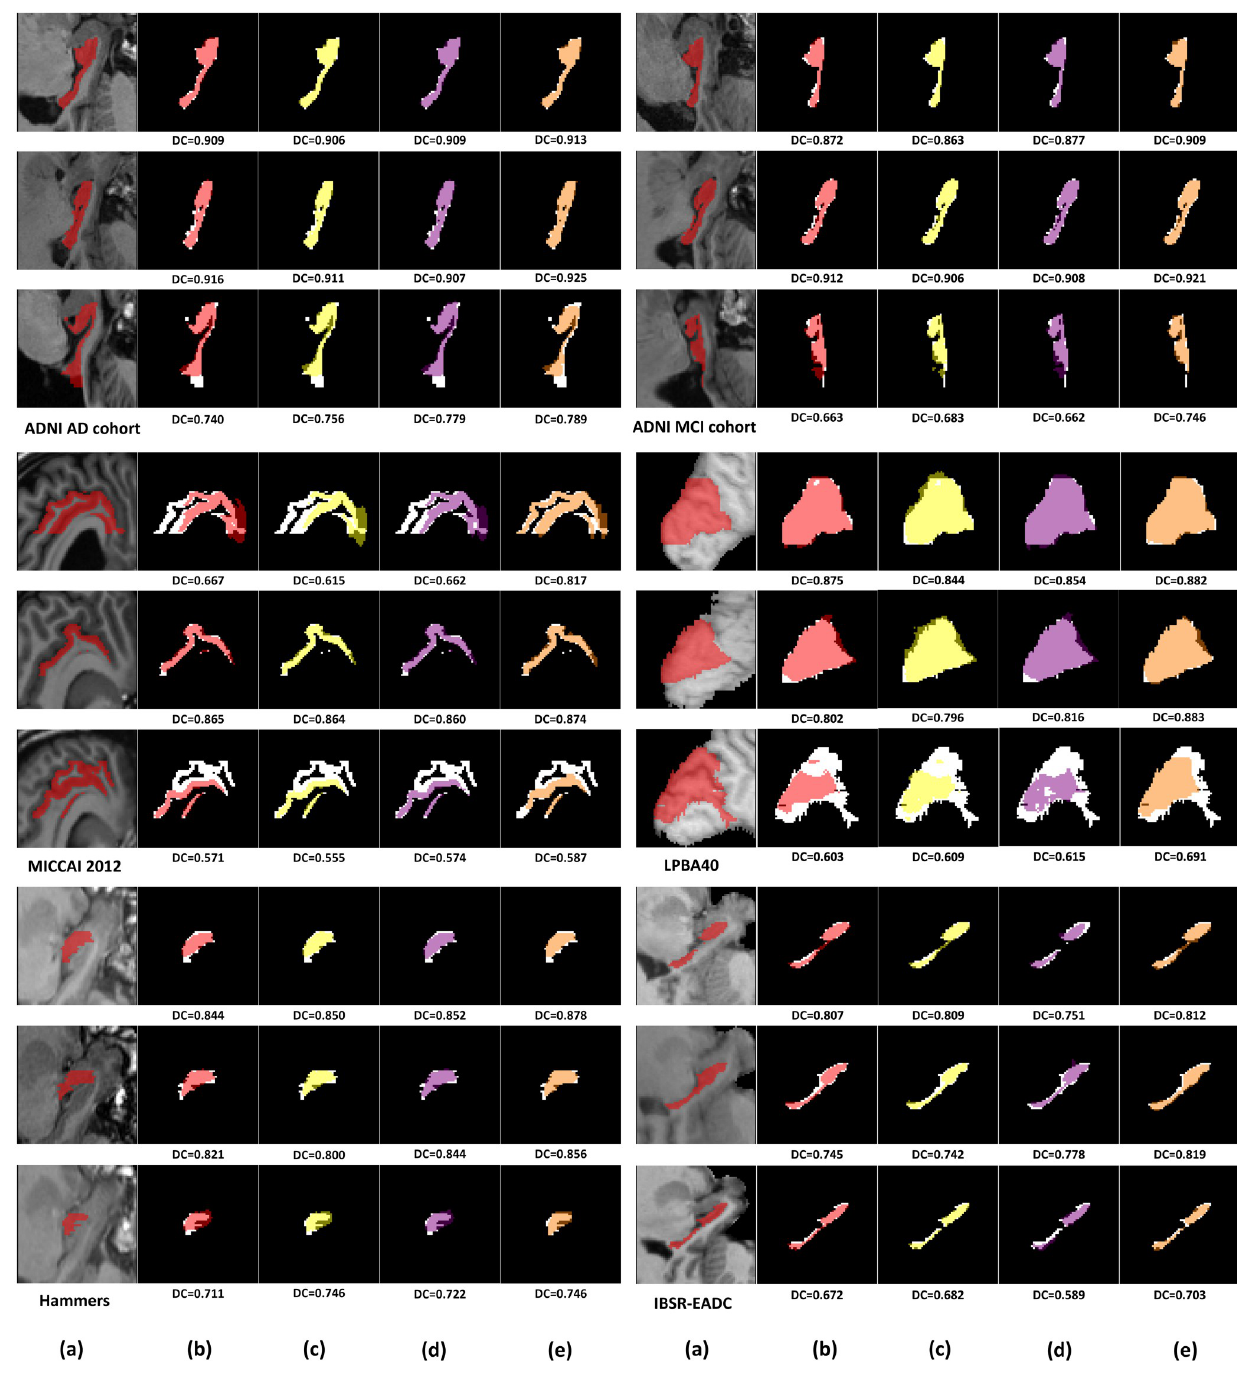
Fig 6. Final fusion segmentation results of four best-performing systems. Three target images are chosen for demonstration in each dataset or cohort. Cuneus sub-volumes in the LPBA40 dataset are shown as sagittal slices while all the other volumes are represented by coronal slices. (a) Target image and ground truth. (b) ANTs SyN + Joint Label Fusion. (c) Elastix + Joint Label Fusion. (d) ANTs SyN + Learning to Rank + Joint Label Fusion. (e) integrated flow + atlas selection + label transfer (our system). Ground truth segmentation is also shown in white color below each resulting segmentation in (b)-(e) for reference. DC: the Dice